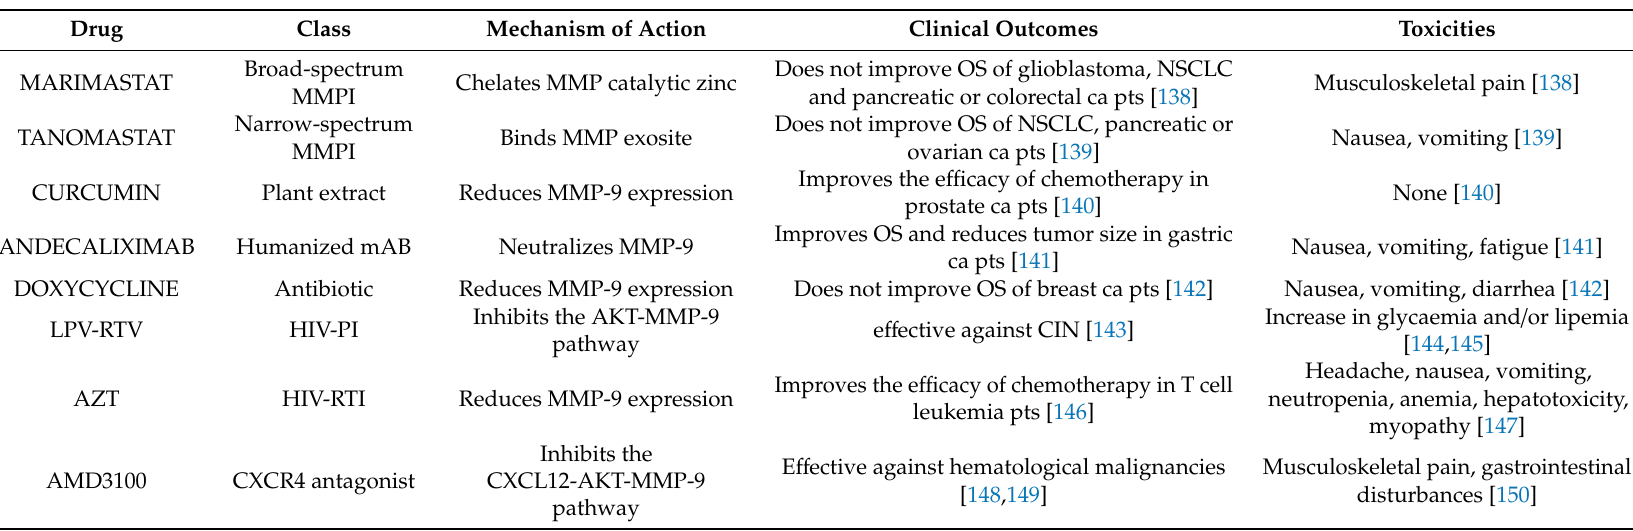
Table 2. Mechanism of action, clinical outcomes and toxicities of compounds inhibiting MMP-9 expression and / or